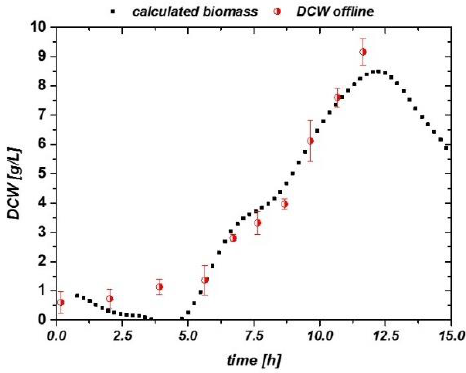
Figure 9. Impedance signal vs. DCW for the inline probe in complex medium: malt extract. A good description is found beyond 1 g/L DCW in this experiment.